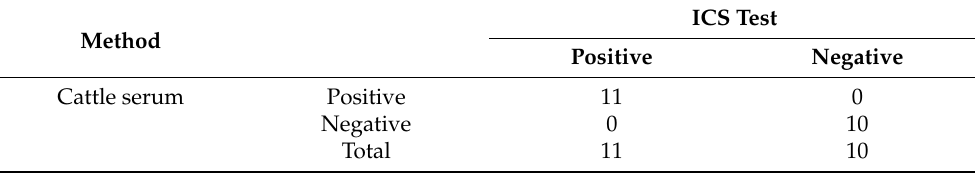
Table 2. Determination of antibodies in non-infected and infected cattle serum using ICS test.